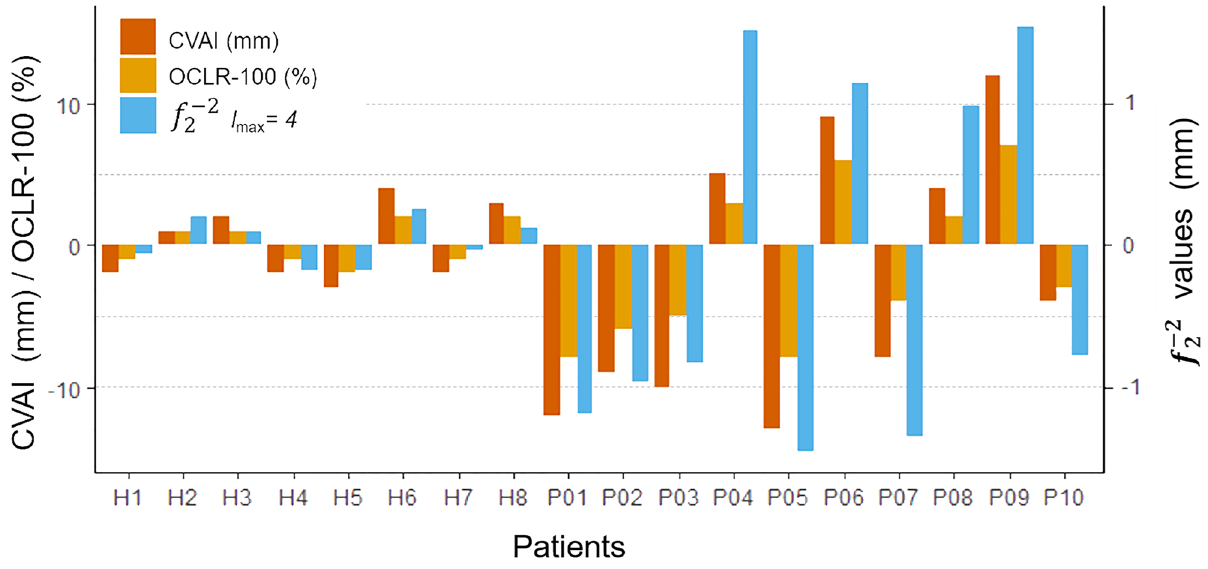
− 2 2 lmax = 4 for the two